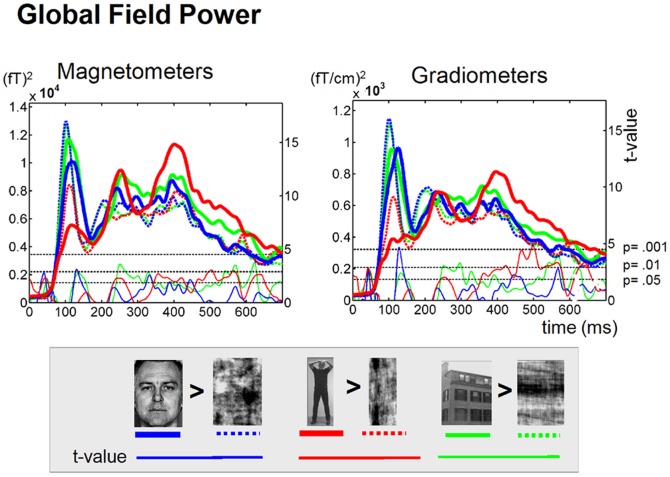
Mean global field power of face and body evoked MEG activity.The grand average (n = 10 subjects) of the mean Global Field Power (GFP) of the magnetometer and planar gradiometer sensors evoked by photographs of intact (solid lines) Faces (blue), Bodies (red) and Houses (green) and their Scrambled counterparts (dotted lines). Shown are the mean current strength (thick Lines) for the single conditions and the corresponding t-values (thin lines) for the contrast Intact>Scrambled (paired t-tests, one-sided, n = 10 subjects, df = 9) with color corresponding to category (Faces = blue; Bodies = red; Houses = green). The dotted black horizontal lines indicate the t-levels that correspond to the p-values of 0.05 and 0.01 and 0.001.